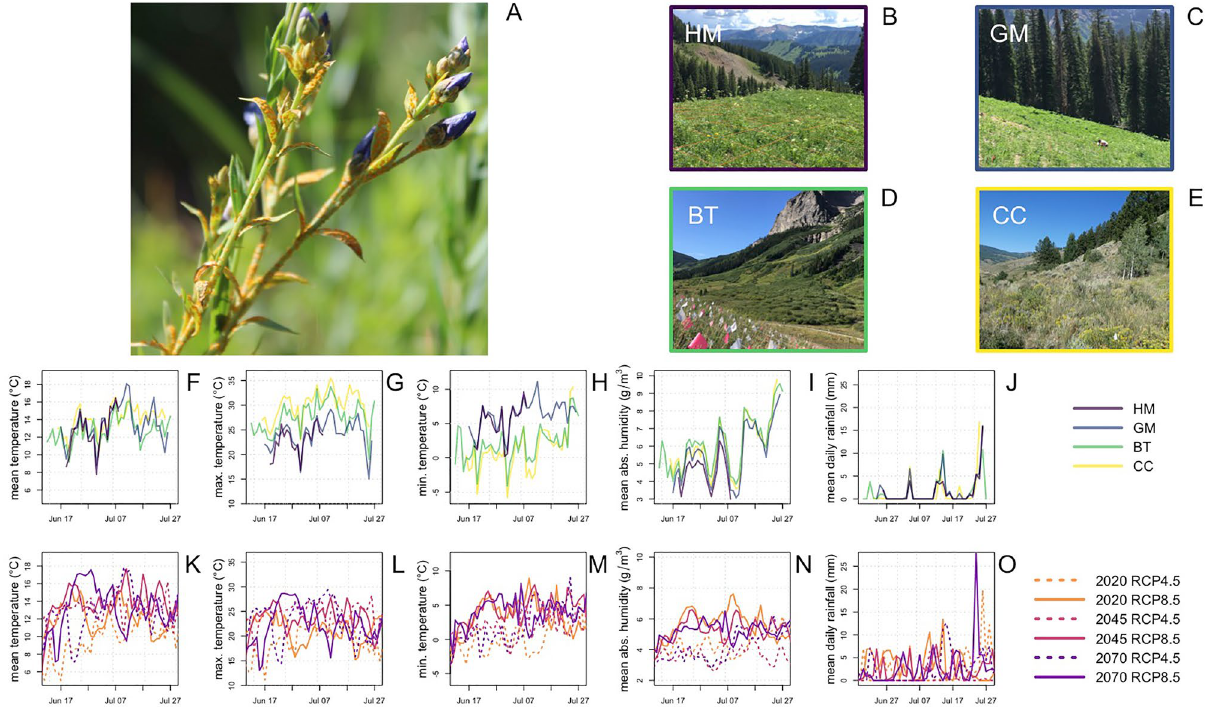
Figure 1. The flax rust study system. Panel ( A ) shows a L. lewisii plant infected with M. lini. Panels ( B – E ) shows photographs of the ‘high meadow’, ‘gothic mountain’, ‘bus turnaround’ and ‘cement creek’ (hereafter HM, GM, BT, CC) sites. These sites are located at approximately 2440 m, 2940 m, 3200 m, and 3410 m elevation respectively. Panels ( F – J ) show observed weather data collected at each site over the duration of the study period, which occurred in June and July of 2020. Panels ( K – O ) show weather data projected for the area surrounding the BT study site. These projections were generated for future climate scenarios encompassing the RCP 4.5 (dashed lines) and 8.5 (solid lines) emissions pathways for the years 2020 (year of observations, orange lines), 2030, 2040, 2045 (magenta lines), 2050, 2060, and 2070 (purple lines). The RCP 4.5 projections correspond to an intermediate scenario in which emissions begin to decline by approximately 2050, and the RCP 8.5 projections correspond to a more pessimistic scenario in which emissions increase through 2100 17